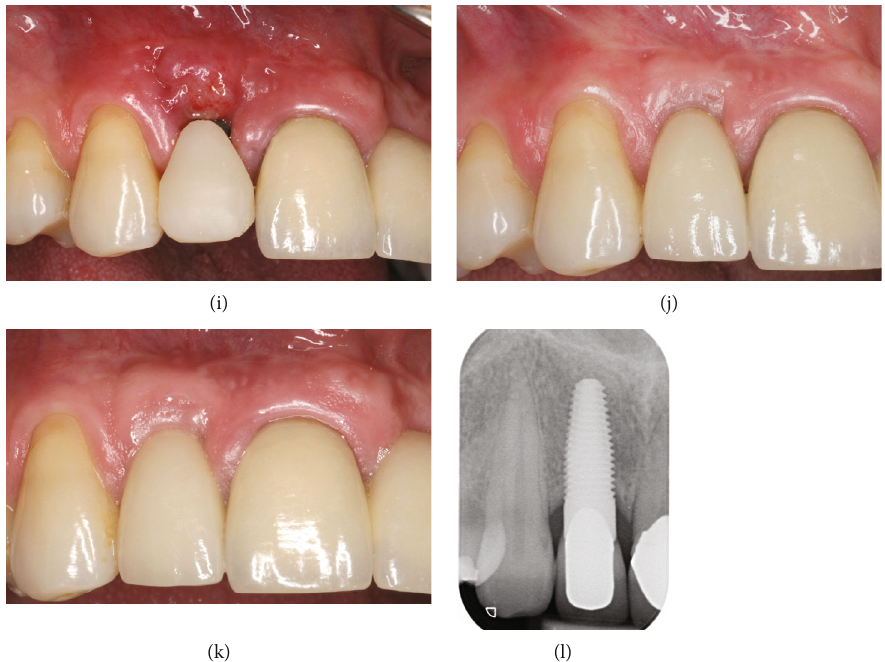
Figure 6: Delayed implantation of one-piece implant in esthetic zone: (a) clinical situation after extraction and socket preservation with soft- tissue augmentation; (b) clinical situation presurgically presenting small horizontal dimension of alveolar ridge; (c) re fl ection of connective tissue pedicle using roll technique with implant placement; (d) initial radiographic situation with hopeless tooth; (e) clinical situation after implant placement; (f) suturing and fi xation of connective tissue at the buccal site; (g) healing after one week and suture removal, immediate provisional restoration (occlusal view); (h) radiographic control after implantation; (i) healing period one week after implantation with provisional restoration (buccal view); (j) prosthetic restoration with single crown four months after healing; (k) clinical situation 10 years after intervention; (l) radiographic control 10 years after implant